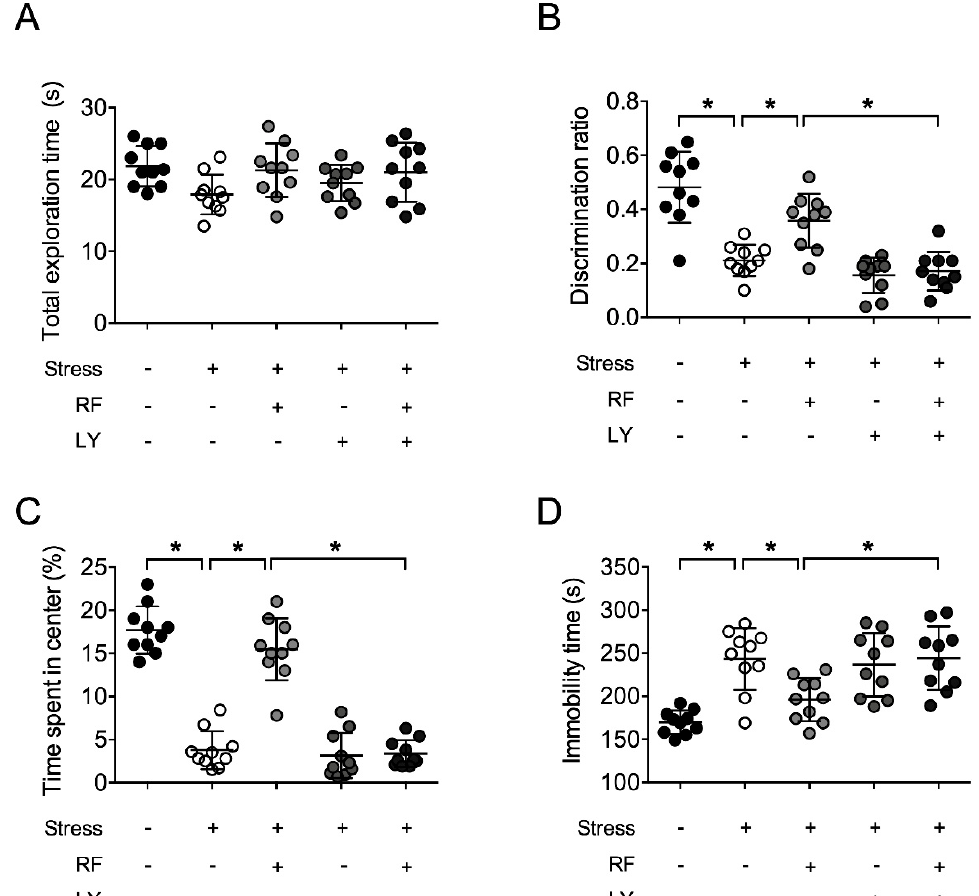
Figure 8. E ff ect of LY294002 on the e ff ect of rubrofusarin on depressive symptoms: Mice were treated with LY204002 (1nmol, 3 µ L, intracerebroventricular injection (i.c.v.)) 30 min before rubrofusarin treatment. Rubrofusarin was administered to mice 1 h before restraint stress protocol. ( A ) Total exploration time for objects in training trial of object recognition test. ( B ) Discrimination ration in test trial of object recognition test. ( C ) Time spent in center of open field in the habituation trial of object recognition test. ( D ) Immobility time in forced swimming test. Data represented as mean ± SD with raw data. * p < 0.05.